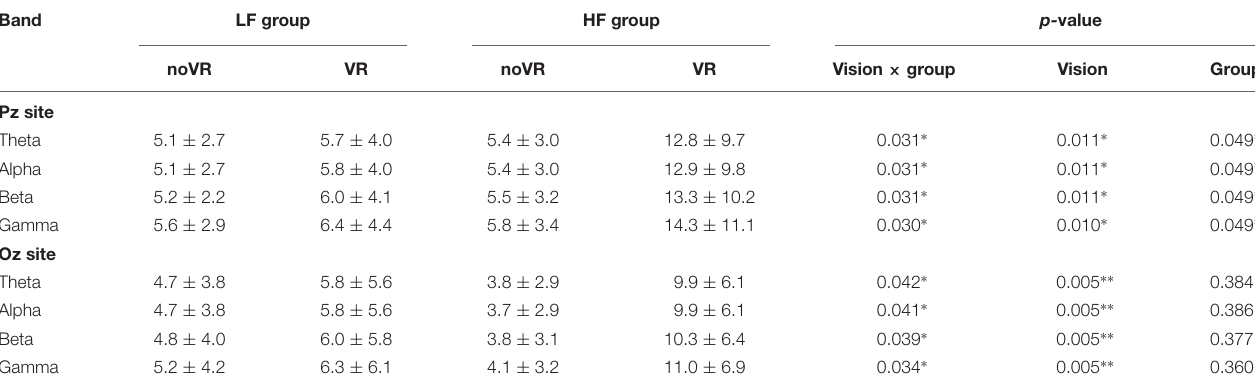
TABLE 1 | Results of the relative power spectrum density (PSD) analysis by two-way repeated measure ANOVA of the Pz and Oz sites during the platform recovery phase with or without virtual reality. Band LF group HF group p- value